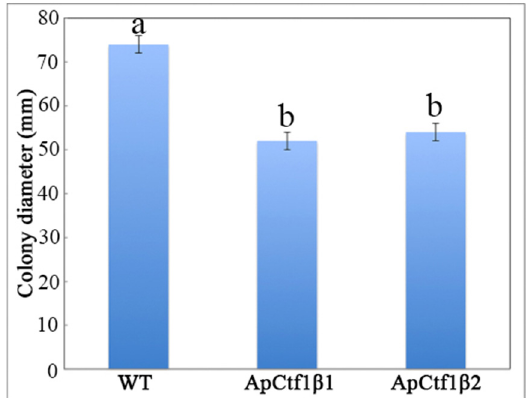
Figure 10. WT, ApCtf1 β 1 and ApCtf1 β 2 colony diameter after 7 days of culture at 25 °C. Note: WT, ApCtf1 β 1 and ApCtf1 β 2 show the colony diameters of the wild-type, Ctf1 β 1 deletion mutant and Ctf1 β 2 deletion mutant of A. phaeospermum after culturing for 7 days, respectively. All assays were repeated three times, the data were analyzed using one-way ANOVA and Duncan’s range test in SPSS 16.0. Different lowercase letters showed significant differences in colony diameter of strains ( p ≤ 0.01).